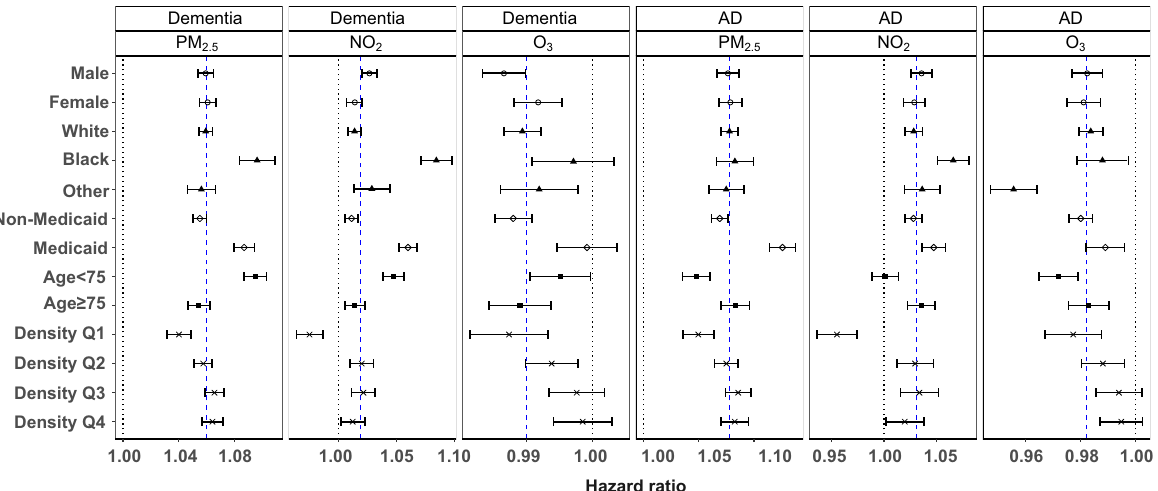
Fig. 4 Effect modi fi cations by sex, race, Medicaid eligibility, age, and population density. Results represent the hazard ratios of dementia ( n = 12,233,371 individuals examined) or Alzheimer ’ s disease (AD, n = 12,456,447 individuals examined), from the tri-pollutant models, per IQR increase in 5-year average PM 2.5 , NO 2 , or O 3 . Error bars stand for the 95% con fi dence intervals. The blue dashed lines indicate the overall effect estimates for all groups. “ Other ” includes Asian, Hispanic, American Indian or Alaskan Native, and unknown. “ Density Q1 – Q4 ” denotes quartiles of population density, i.e., low population density, low-medium population density, medium-high population density, and high population density. Source data are provided as a Source Data fi